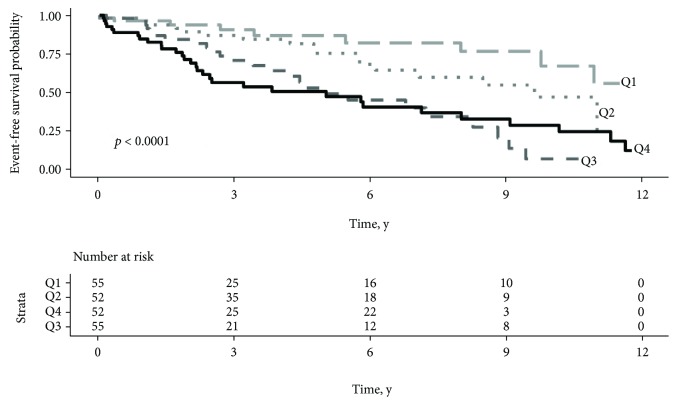
Barcelona Bio-HF score and composite outcome prediction. Event-free survival probability according to mortality risk predicted by the Barcelona Bio-Heart Failure score. Study population was stratified by quartiles of 1-year mortality risk (Q1: risk < 1.56%, Q2: 1.56 ≤ risk < 3.45%, Q3: 3.45 ≤ risk < 6.68%, and Q4: risk > 6.68%). p value refers to the log-rank test.